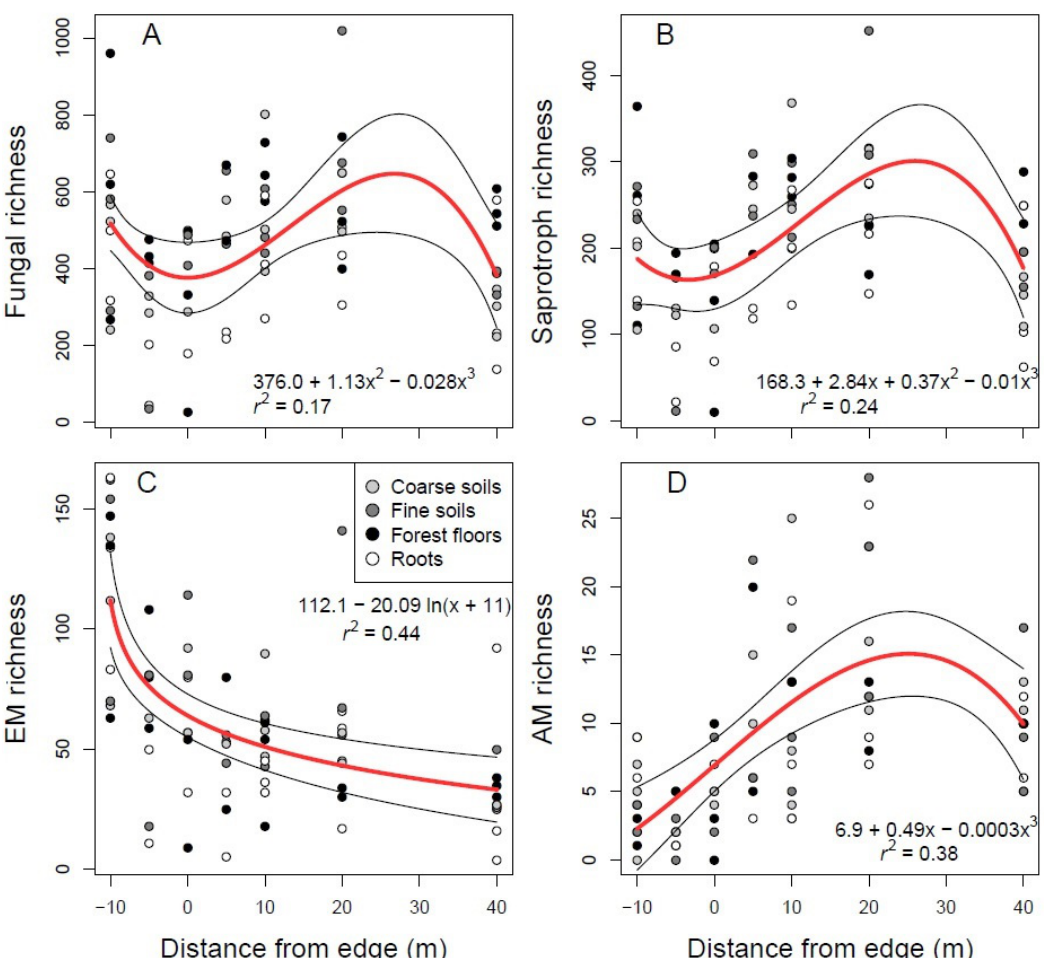
Figure 2. Best-fit modeled responses of fungal richness to distance from the forest edge (red lines), with 99% confidence interval (black lines), where negative distance values represent the forest interior and positive distance values represent the reclaimed area. ( A ) All fungi; ( B ) saprotrophs; ( C ) ectomycorrhizae (EM); and ( D ) arbuscular mycorrhizae (AM).